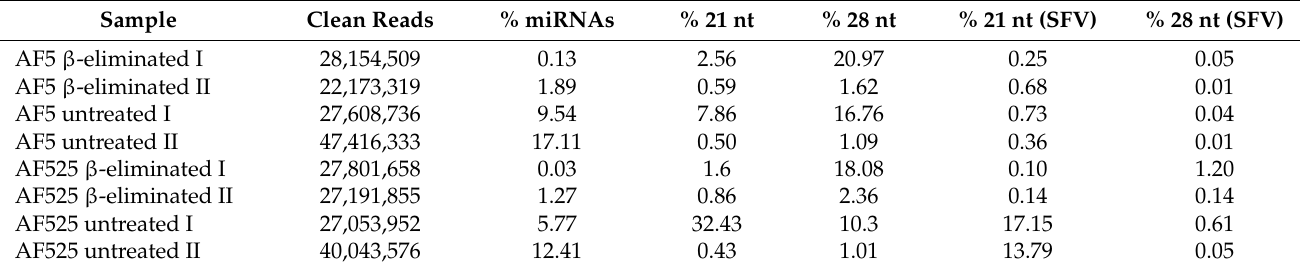
Table 1. Analysis of clean reads for SFV4-infected AF5 and AF525 samples treated with β -elimination reagents. Total number of clean reads is listed for each sample, as well as percentage of miRNAs detected in the sample. Furthermore, the percentage of total reads of 21 nt (% 21 nt) and 28 nt long RNAs (% 28 nt) and the share of those RNAs mapping to SFV4, termed % 21 nt (SFV) and % 28 nt (SFV), respectively, are also shown. As a representative for siRNAs, 21 nt reads are shown, and 28 nt long reads as a representative for piRNAs. Data from two independent sequencing runs are